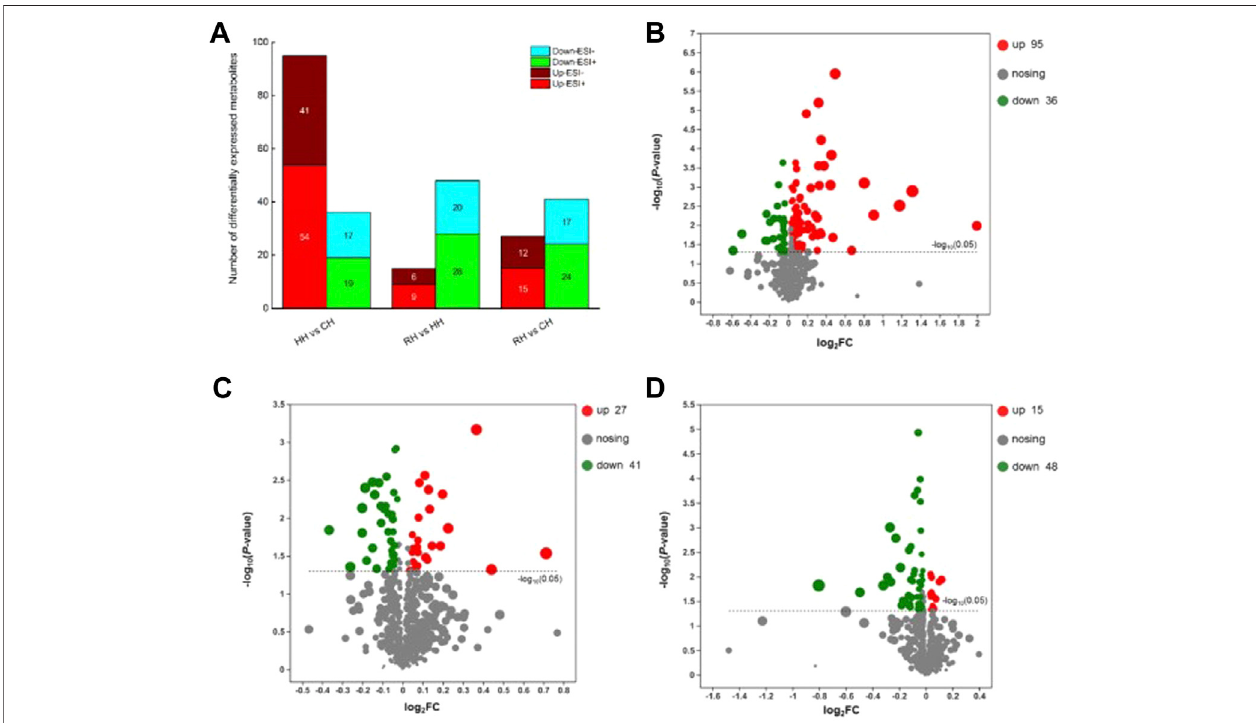
FIGURE 4 | Statistics for metabolites of differential expression among the three comparative groups. Note: (A) : Overview of different metabolites between two comparisongroups; (B) :Thevolcanic fi gureofdifferentialexpressedmetabolitesinHH vs .CHgroups; (C) :Thevolcanic fi gureofdifferentialexpressedmetabolitesinRH vs . HH groups; (D) : The volcanic fi gure of differential expressed metabolites in RH vs . CH